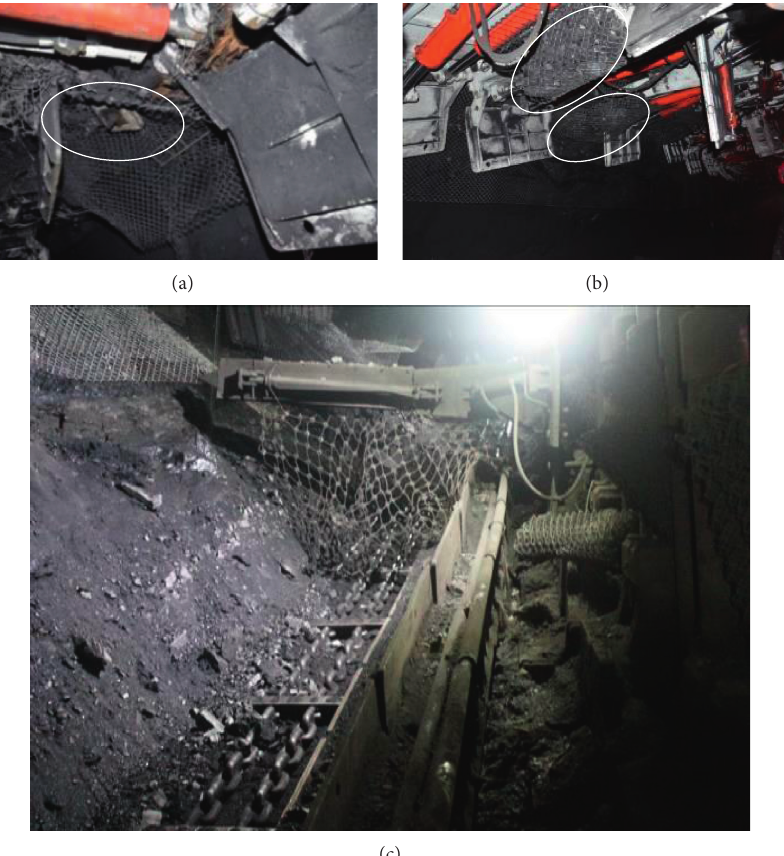
Figure 2: Disasters in the SDCS working face. (a) Spalling and roof collapse [15]. (b) Falling of gangues between supports [15]. (c) Spalling- caused overturning of the working face